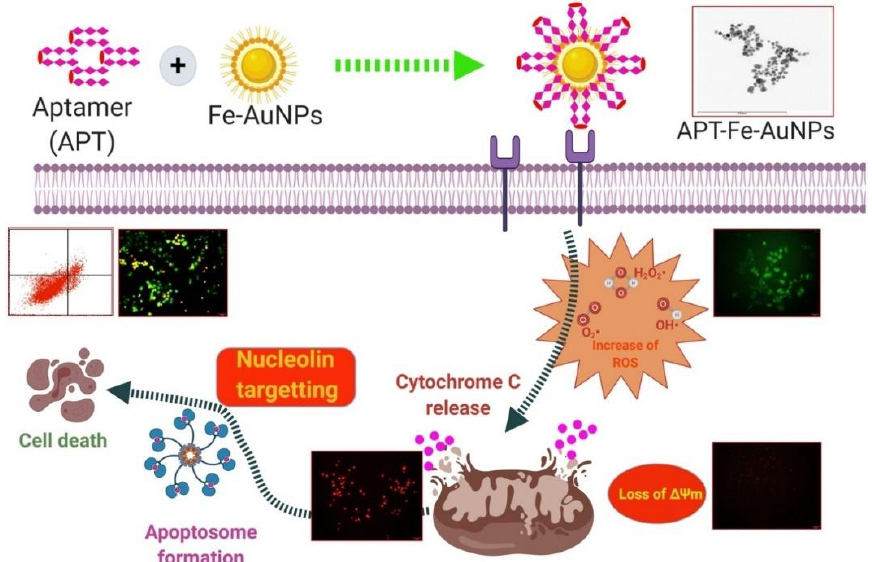
Figure 2. Schematic illustration of nucleolin targeted delivery of APT-FE-AuNPs to improve cytotoxicity in cancer cells [98].